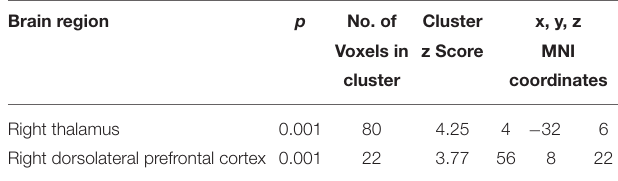
TABLE 4 | Brain regions identified in the correlational analysis in the PHB group during exposure to sexual